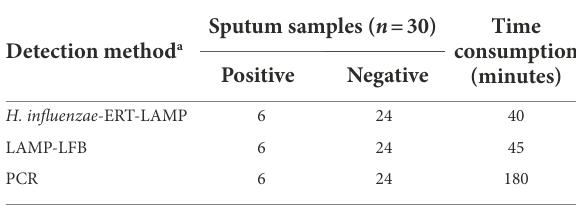
TABLE 3 Comparison of H. influenzae -ERT-LAMP, LAMP-LFB, and PCR Assays for the Detection of H.